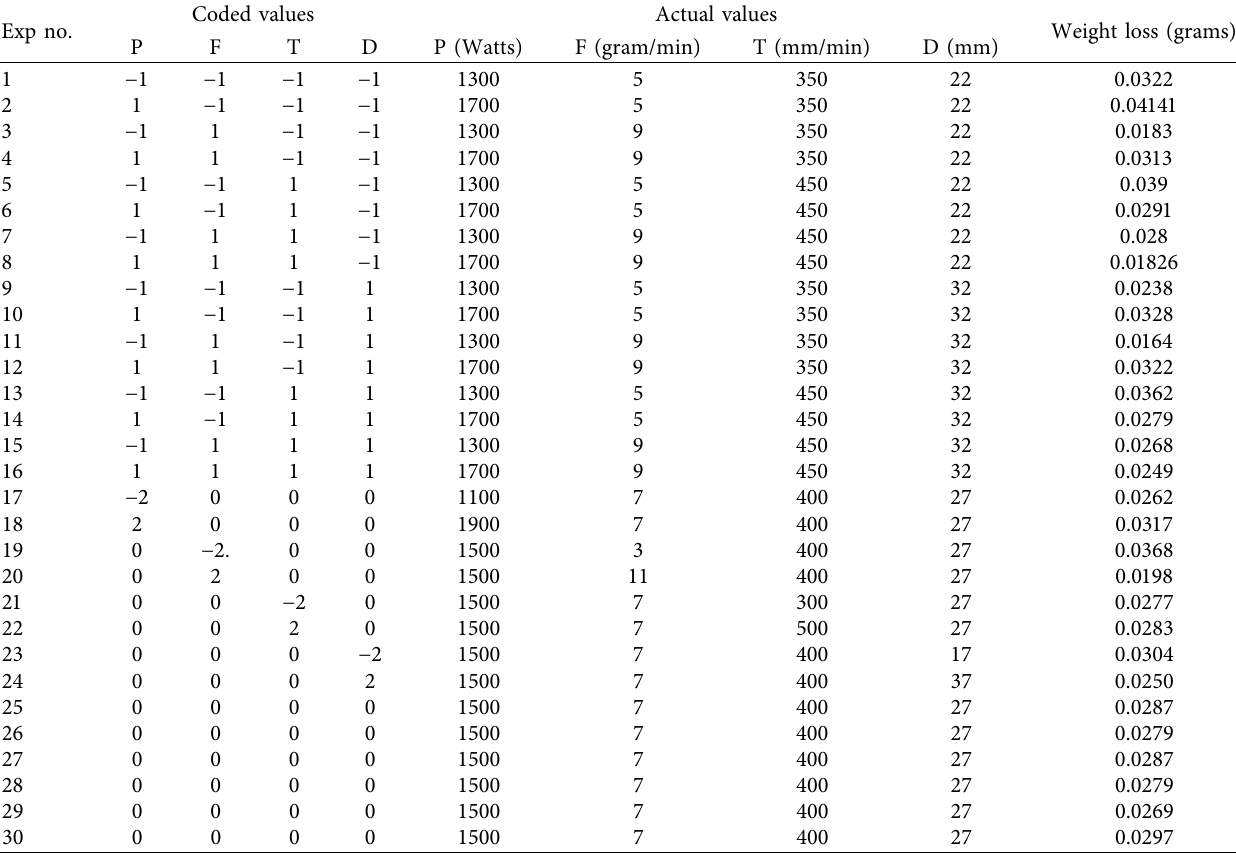
Table 6: The design matrix and the experiment